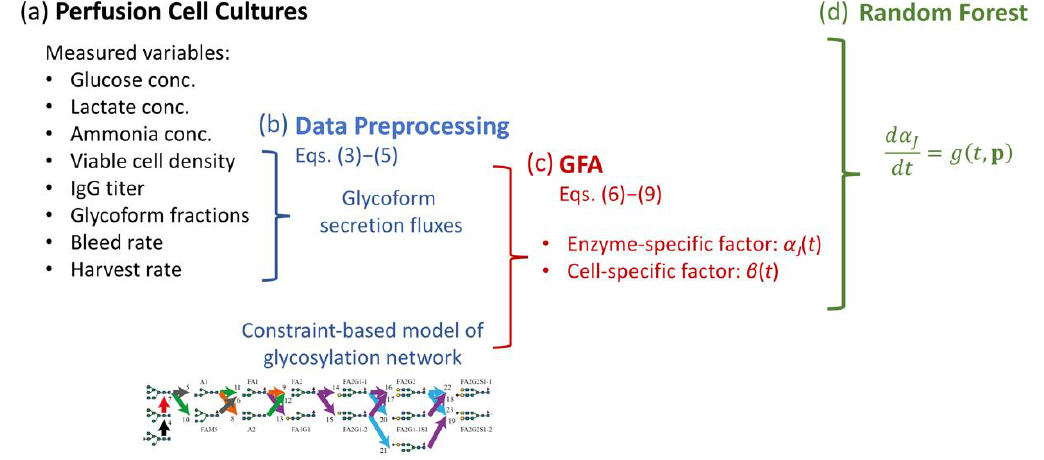
Figure 1. Analysis procedure of IgG glycosylation in CHO perfusion cell cultures. ( a ) Four perfusion cell cultures were performed (see Section 2.1). Measurements of glucose/lactate/ammonia concentrations, viable cell density, IgG titer, glycoform fractions, bleed rates and harvest rates were taken from each cell culture run. ( b ) In the data preprocessing step (see Section 2.2), the cell-specific secretion fluxes of IgG glycoforms, as well as the cell-specific secretion/uptake rates of IgG, glucose, lactate and ammonia, were computed. ( c ) The glycosylation flux analysis (GFA) was applied to the secretion fluxes of IgG and its glycoforms (see Section 2.3). The GFA is based on a constraint-based model of the glycosylation network where the glycosylation fluxes vary with time according to two multiplicative factors: the enzyme-specific factor α J ( t ) and the cell-specific factor β ( t ) . The factor α J ( t ) captures the dynamic changes in the enzyme-specific glycosylation activities, while the factor β ( t ) describes the dynamic changes in the cell-specific IgG productivity. ( d ) A random forest regression analysis was carried out to rank the process parameters ( p ) based on their ability to predict the dynamic changes of α J ( t ) .